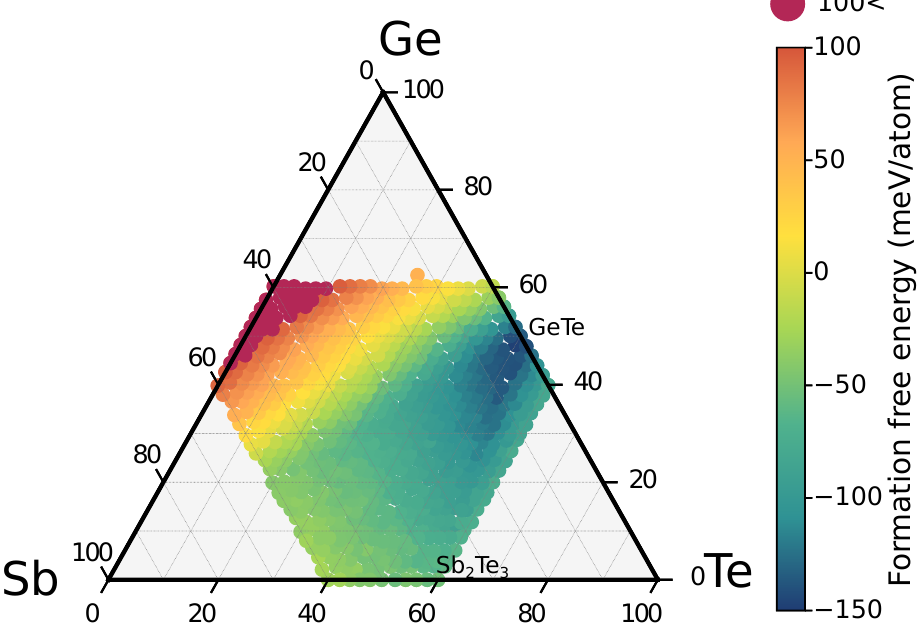
Figure 1. Map of the formation free energy of GST alloys in the metastable cubic phase (at 300 K, see text). The GeTe compound is instead in the stable trigonal phase. The topmost point corresponds to